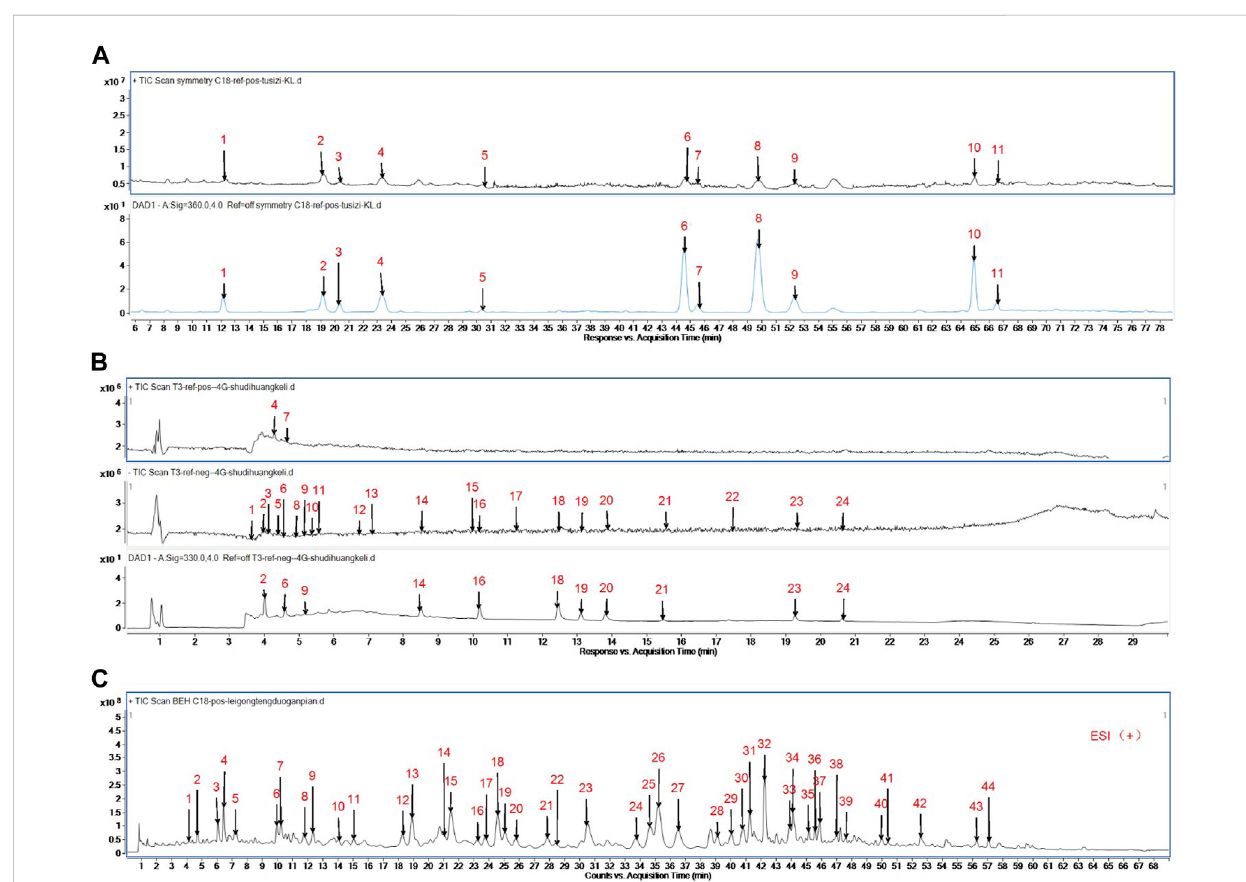
FIGURE 1 (A) AnalysisofPreparedCuscutaesemenDispensingGranulesbyMassSpectrometry.Peak1:Neochlorogenicacid;Peak2:ChlorogenicAcid;Peak3: Quercetin 3-O- β - D-galactosyl-7-O- β - D-glucoside; Peak 4:Cryptochlorogenic acid; Peak 5:Rutin; Peak 6:Quercetin-3-O-apiose - (1 → 2) - galactoside; Peak 7:Quercetin 3-O- β - D-galactoside (2 → 1)- β - D-glucoside; Peak 8:Hyperoside; Peak 9:Isoquercitrin; Peak 10:Astragalin; Peak 11: Isorhamnetin7-O- β -D-glucopyranoside. (B) Analysis ofPrepared RadixrehmanniaepraeparataDispensing Granules byMassSpectrometry. Peak 1: catalpol; Peak 2: 5-hydroxymethylfurfural diglucoside; Peak 3: Rehmannin D; Peak 4: 5-hydroxymethylfurfural; Peak 5: Melittoside; Peak 6: Geniposidic acid; Peak 7: adenosine; Peak 8: Ajugol; Peak 9: 8-Epi-Loganic acid; Peak 10: Verbasoside; Peak 11: aucubin; Peak 12: rehmapicrogenin; Peak 13: Kanokoside A; Peak 14: Purpureaside C; Peak 15: Rehmaionoside B; Peak 16: Jionoside A1; Peak 17: Rehmaionoside A; Peak 18: Verbascoside; Peak 19: Jionoside B1; Peak 20: Isoacteoside; Peak 21: Cistanoside C; Peak 22: Jionoside D; Peak 23: Martynoside; Peak 24: Isomartynoside. (C) Analysis of Prepared GTW by Mass Spectrometry. Peak 1:Celacinnine; Peak 2:unknown; Peak 3:TripfordineA; Peak 4:unknown; Peak 5:Wilfordlongin; Peak 6: Wilforjing; Peak 7:A1atusinine; Peak 8:2-O-deacetyl-euonine; Peak 9:wilfordinine B; Peak 10:hypoglaunine E; Peak 11:1-desacetylwilfortrine; Peak 12: Tripterifordin;Peak13:WilfordineE;Peak14:WilfordinineA;Peak15:Wilfortrine;Peak16:Triptonoterpenol;Peak17:wilfortrine;Peak18:PeritassineA;Peak 19:Wilfordeonine; Peak 20:wilfordinine; Peak 21:Wilfordiuetong; Peak 22:Triptoquinone B; Peak 23:Isowilfordine; Peak 24:wilfomine A; Peak 25:9 ″ -O- acetylwilforlrine; Peak 26:Wilforgine; Peak 27:Wilformine; Peak 28:Wilforzine; Peak 29:hypoglaunine C; Peak 30:Triptonoditerpenic acid; Peak